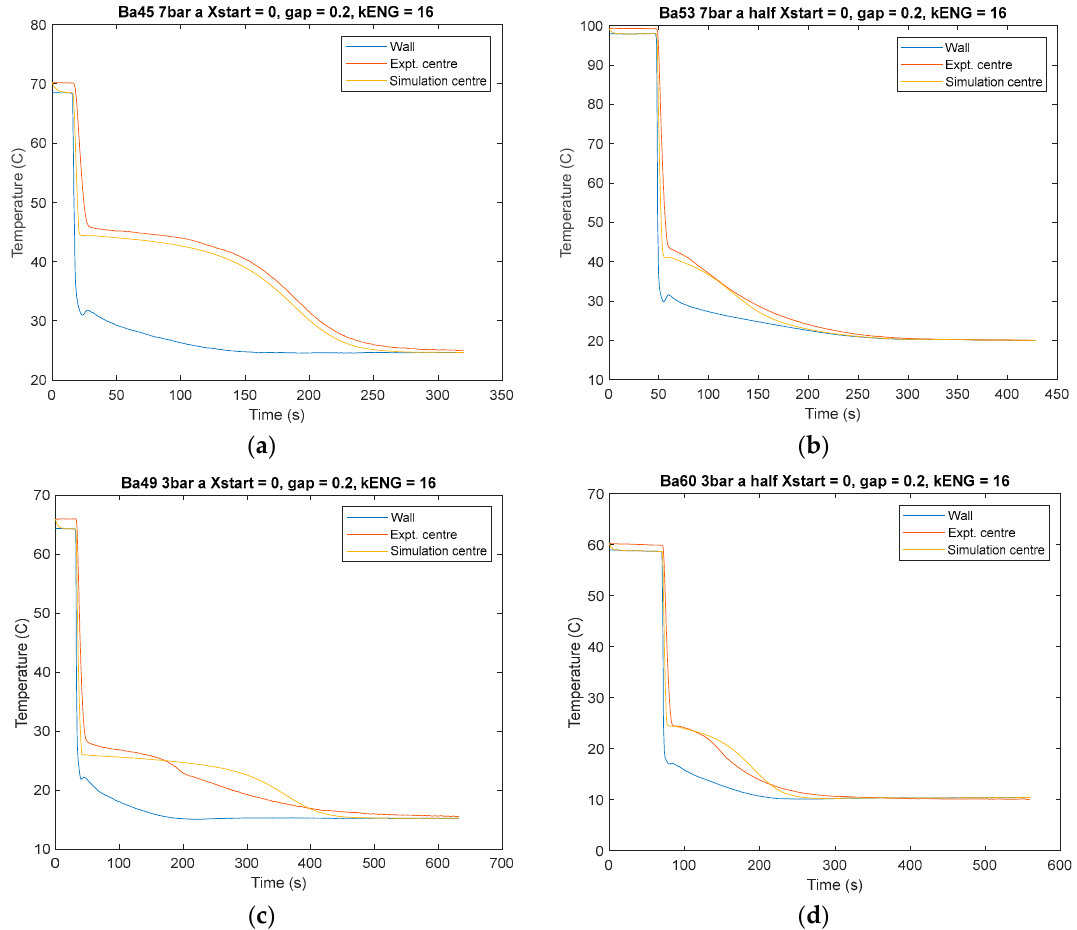
Figure 6. Model results versus measured results for adsorption reaction: ( a ) approx. 7 bar with 0.531 kg salt/kg of composite; ( b ) approx. 7 bar with 0.317 kg salt/kg of composite; ( c ) approx. 3 bar with 0.531 kg salt/kg of composite; ( d ) approx. 3 bar with 0.317 kg salt/kg of composite.